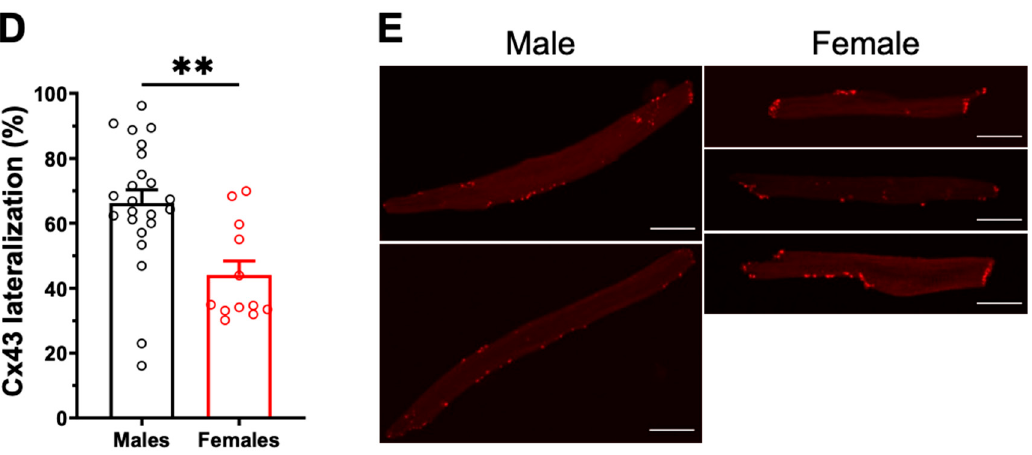
Figure 3. Gene expression and cellular distribution of Cx40 and Cx43. ( A ). No sex differences were observed in mRNA expression of Gja5 (left) and Gja1 (right) encoding for Cx40 and Cx43 (n = 6/group), respectively. ( B ). The percentage of Cx40 lateralization, defined as the percentage of positive signal present at the lateral membrane, is higher in male left atrial myocytes compared to females (M: 63 ± 4 %, n = 22, N = 4; F: 45 ± 4 %, n = 17, N = 3; ** p = 0.005). ( C ). Representative example of the Cx40 distribution (in green) in male and female atrial myocytes. ( D ). Scatter plot of Cx43 lateralization in male and female atrial myocytes (M: 66 ± 4 %, n = 23, N = 4; F: 44 ± 4 %, n = 12, N = 3; ** p = 0.002). ( E ). Representative examples of Cx43 distribution (in red). All scale bars represent 20 µm. ** p < 0.01.